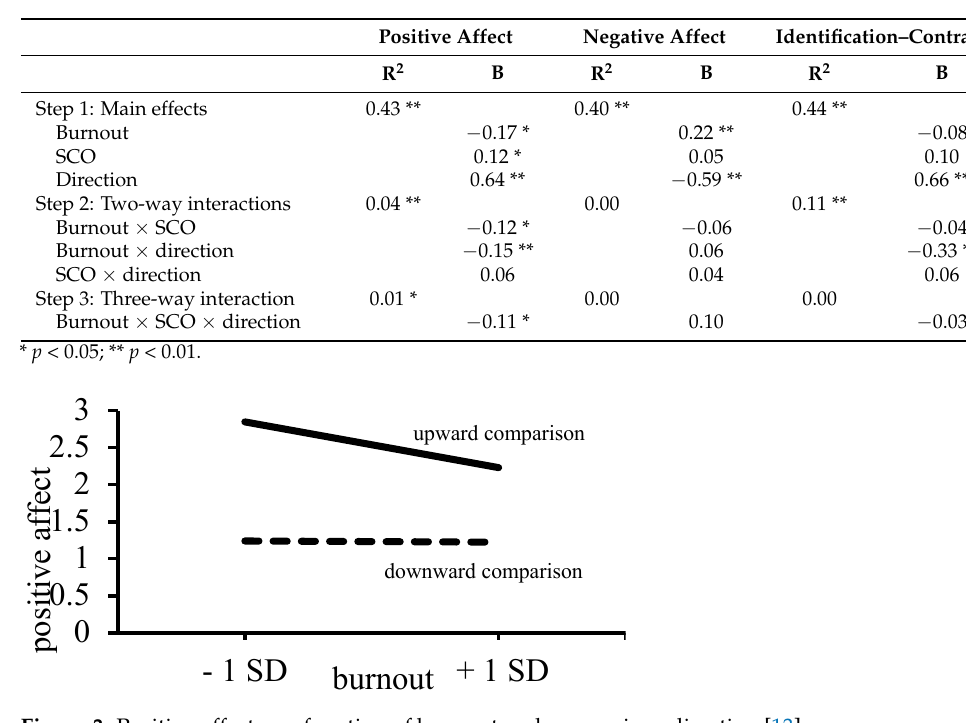
Table 3. Results of hierarchical regression of positive affect, negative affect and identification–contrast on burnout, SCO and comparison direction (Study 2) [13].